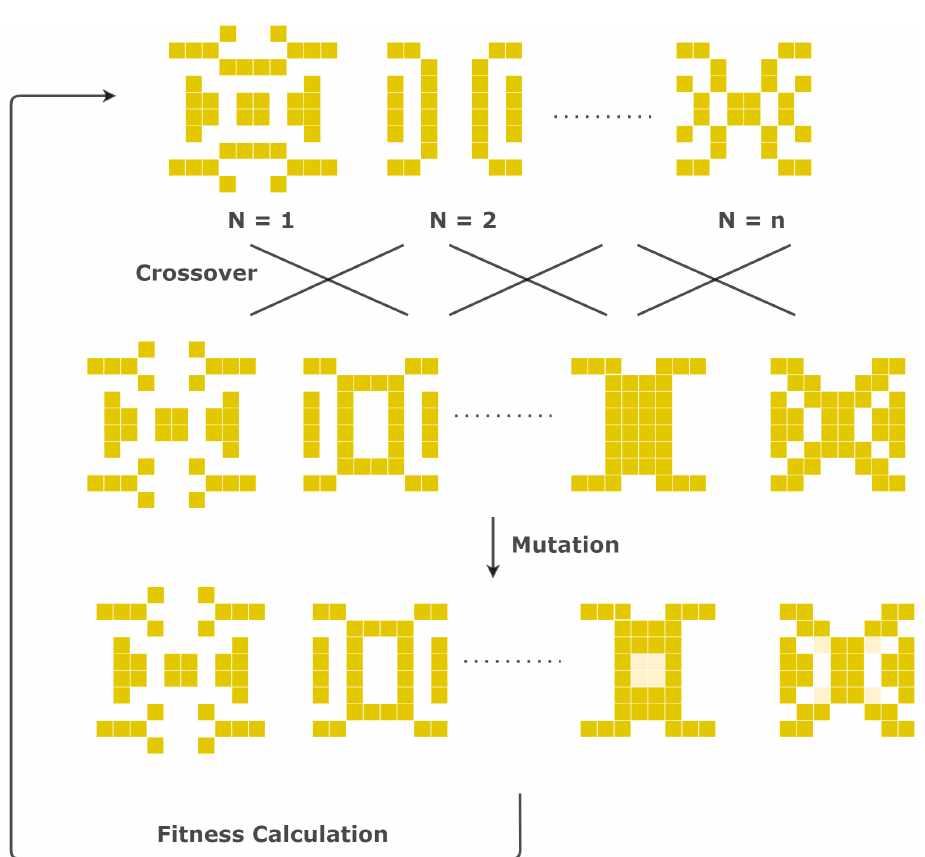
Figure 1. The workflow of one generation of the genetic algorithm (GA). The population number n is determined by the user. The SERS substrates were represented with binary-coded matrices: if it is 1 (or 0), the corresponding pixel is filled with metal (or air). The fitness values are the electromagnetic field enhancement factors and are calculated using the Lumerical FDTD